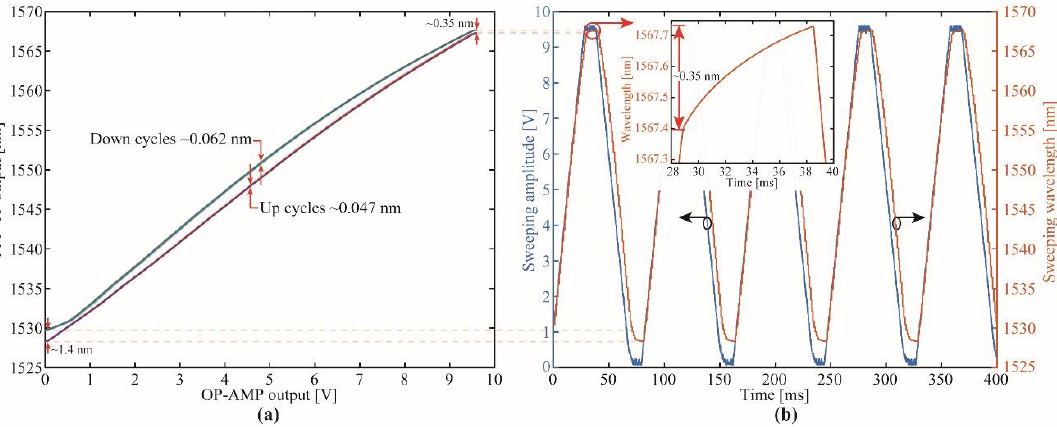
Figure 5. Characterization of the fiber Fabry-Perot tunable filter: ( a ) FTF-TF output as a function of the applied voltage for 11 cycles; ( b ) sweeping wavelength (measured with an Ibsen spectrometer) as a function of sweeping applied voltage (measured with oscilloscope).